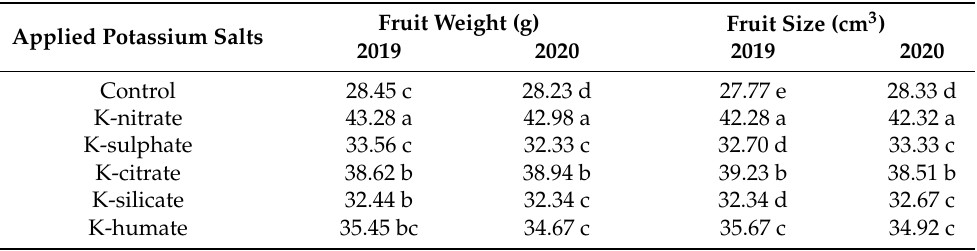
Table 1. Effect of diverse potassium sources as foliar application on average of fruit weight and size of apricot cv. ‘Canino’ trees in 2019 and 2020 seasons.